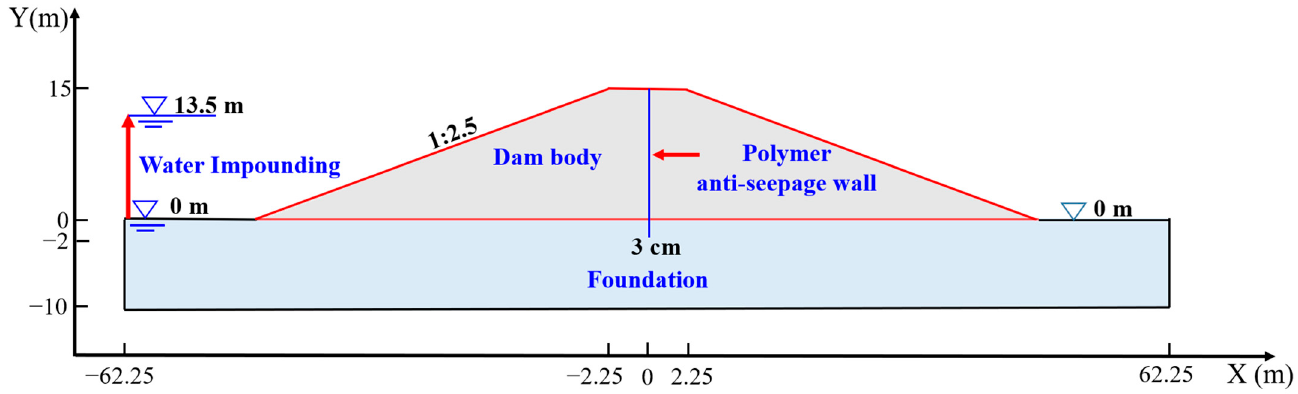
Figure 2. Schematic diagram of coordinate system and model dimensions.